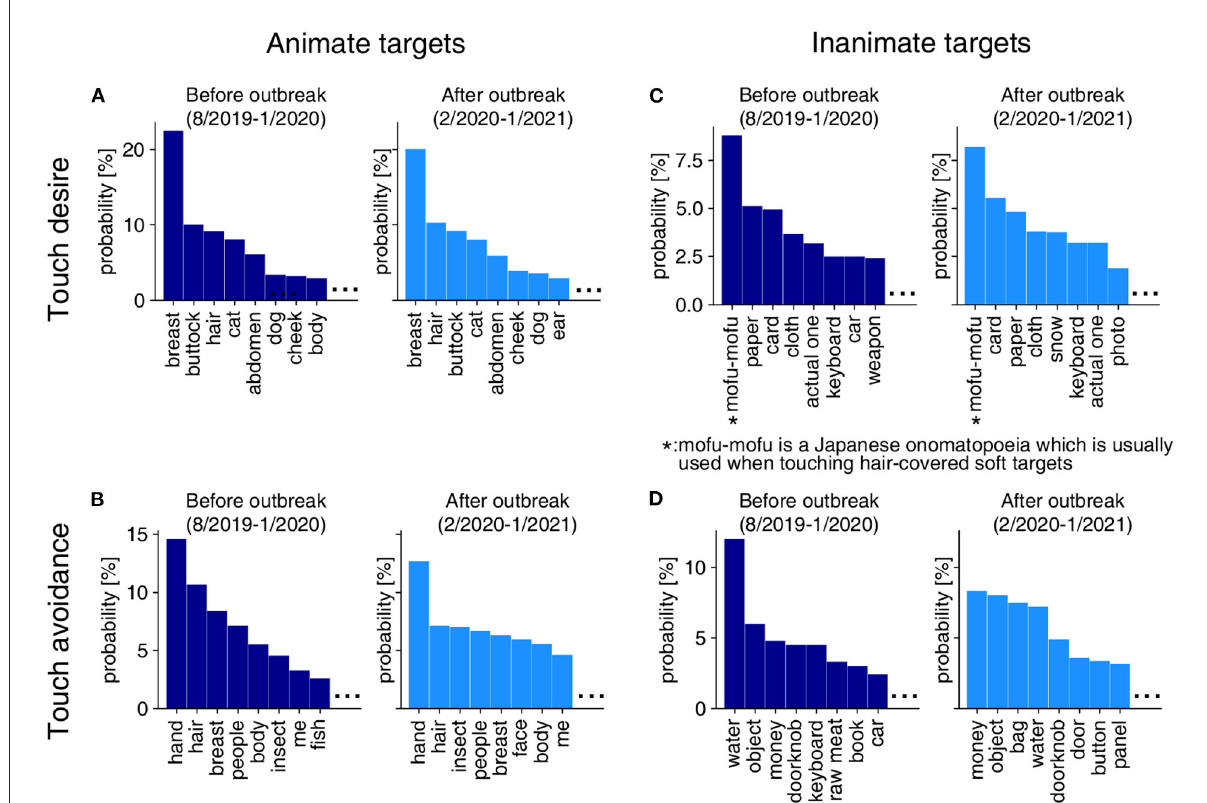
FIGURE4 Probability distribution before and after the outbreak in terms of touch desire and touch avoidance for animate and inanimate targets. Results on touch desire (A) and touch avoidance (B) for animate targets. Results on touch desire (C) and touch avoidance (D) for inanimate